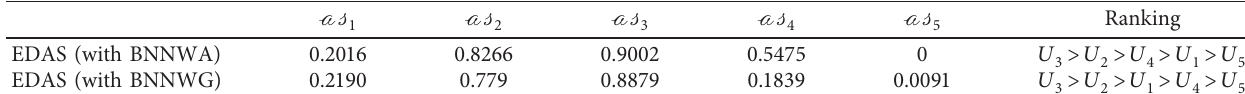
Table 12: The values of as i and the ranking of